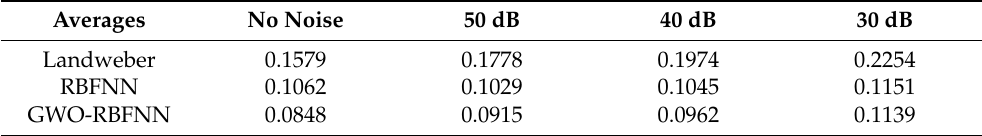
Table 3. Average ICC with noise test